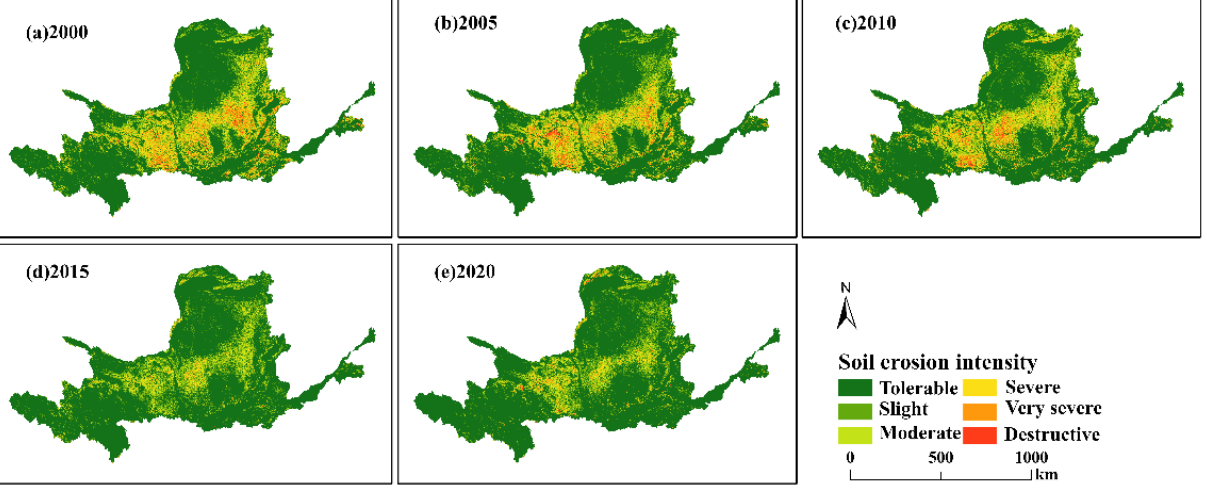
Figure 2. Soil erosion intensity of the YRB.